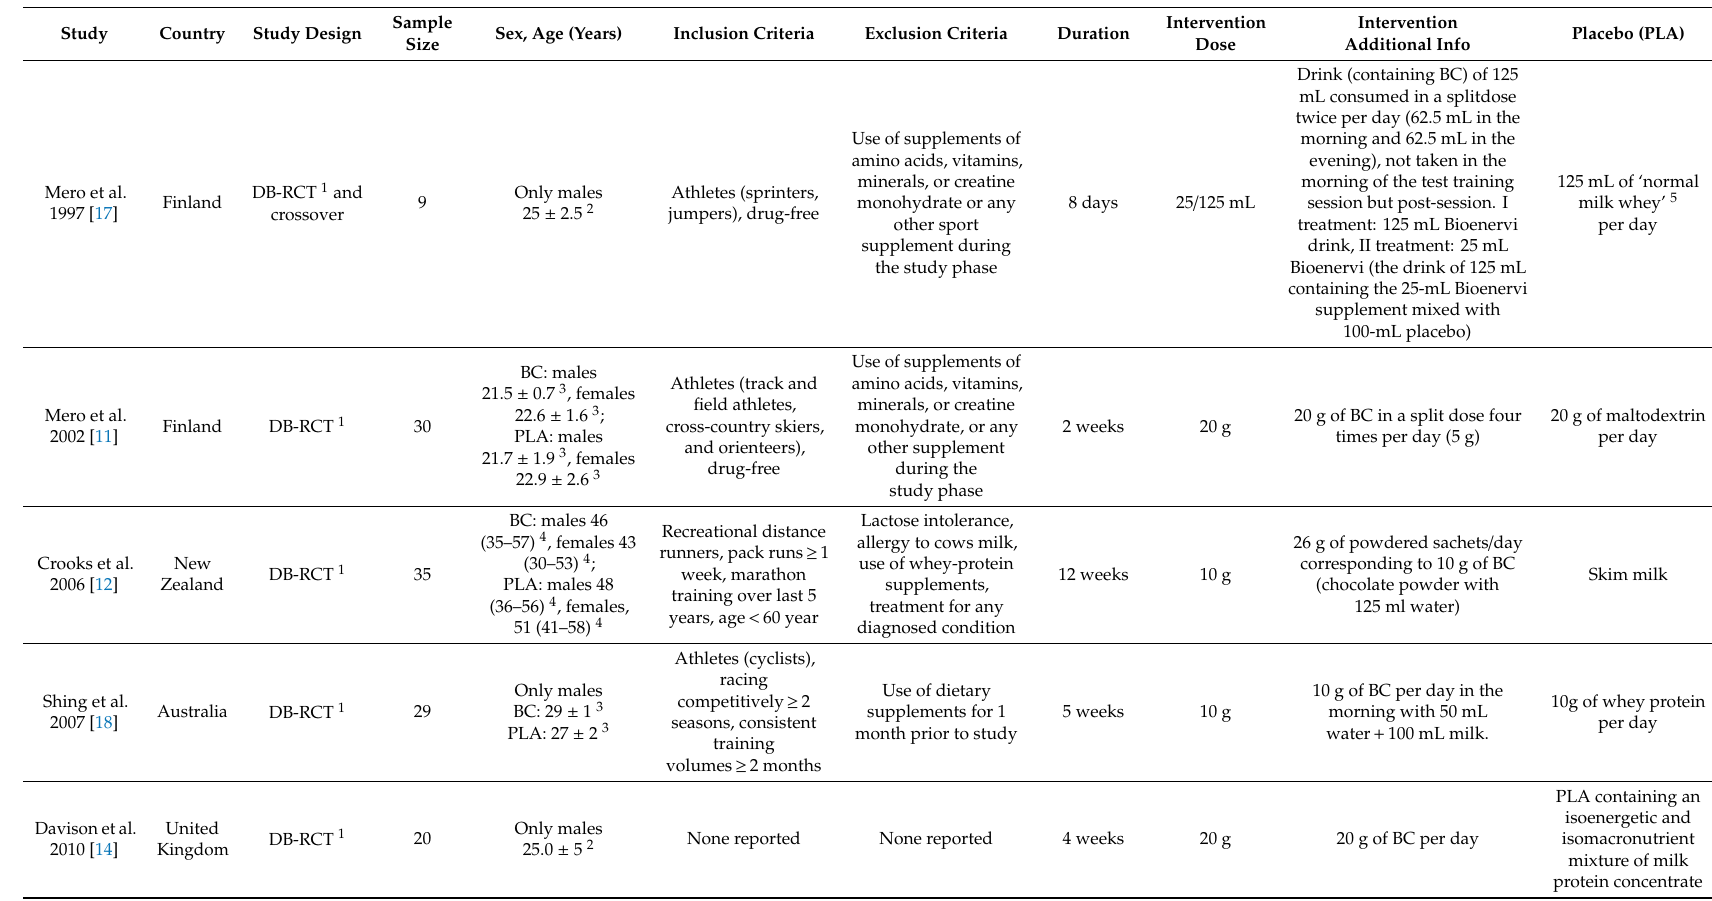
Table 1. Characteristics of included